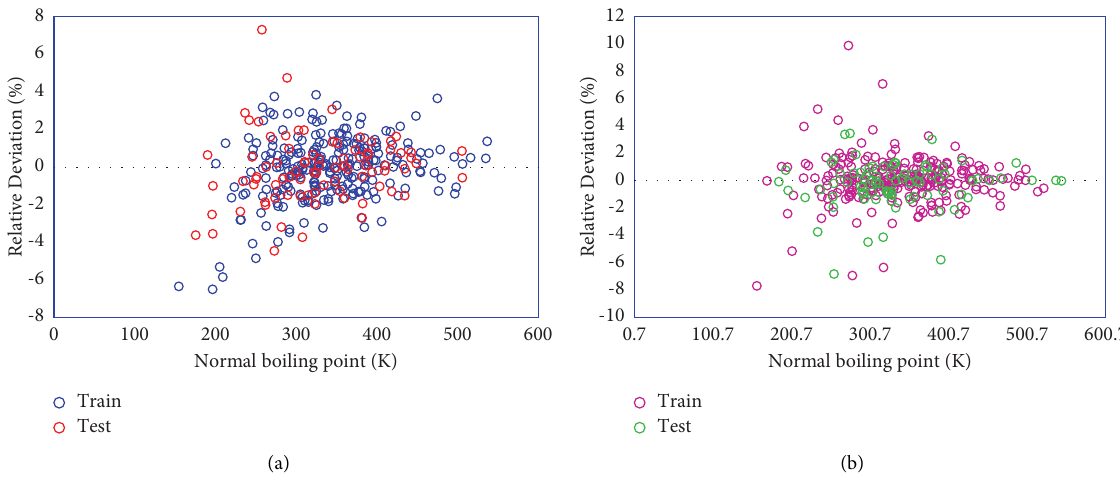
Figure 5: Relative deviation between predicted and experimental normal boiling point (a) EDT boosted (b)